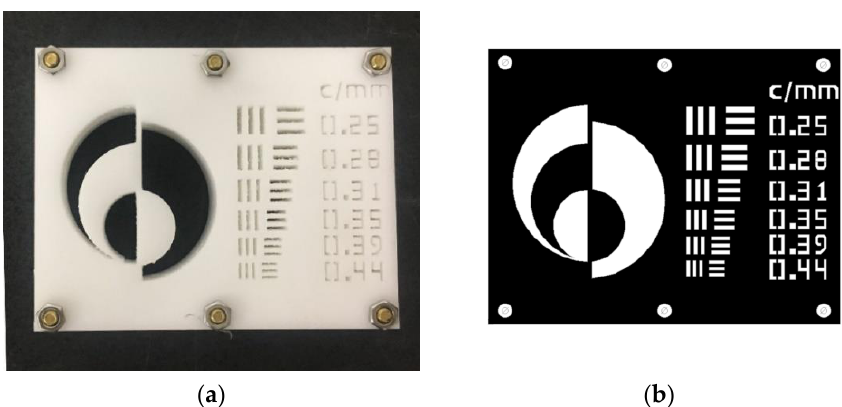
Figure 1. Imaging phantom object—125 mm × 98 mm × 25.4 mm. The spatial frequency of each tri-bar feature is given in cycles per millimeter. ( a ) View from above; ( b ) design.